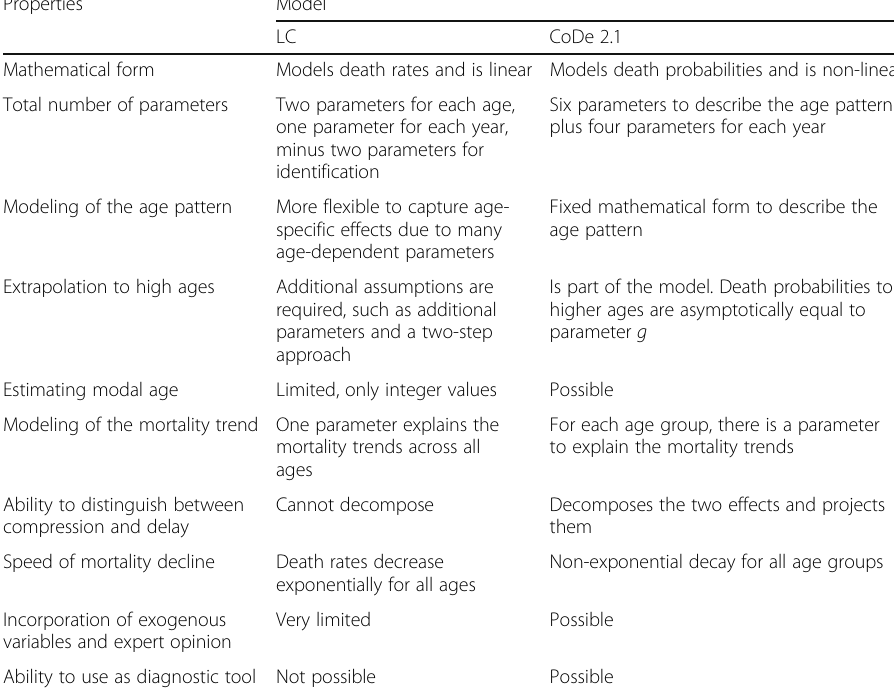
Table 1 Comparison of the underlying assumptions and properties of the CoDe 2.1 model and the LC